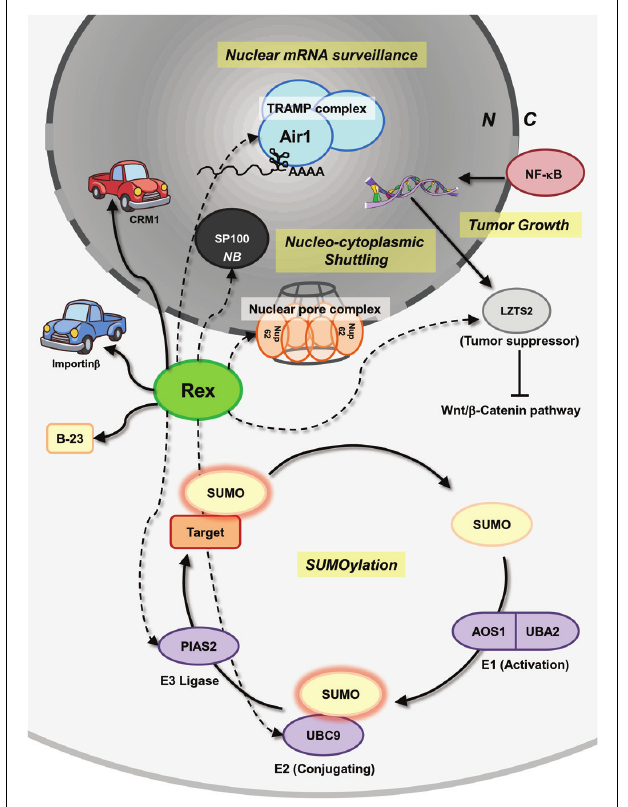
FIGURE 5 | Interactions of Rex with host pathways, uncovered and covered. Besides the known interactions between Rex and CRM-1, importin β , and B-23, a number of potential interactions between Rex and cellular proteins, based on the high-throughput yeast two-hybrid system, were reported by Simonis etal. (2012). Rex is suspected of interacting with a series of proteins that play crucial roles in mRNA surveillance, nucleocytoplasmic shuttling, tumor growth regulation, and SUMOylation. Air1 (ZCCHC7) is a component of theTRAMP complex, which is involved in nuclear mRNA surveillance. NUP62 is one of three nucleoporins (NUP54, 58, and 62) composing the nuclear pore complex and is essential for nuclear transport. LZTS2 is a tumor suppressor and its expression is transcriptionally regulated by NF- κ B. LZTS2 expression levels affect cell proliferation and tumor growth through theWnt/ β -catenin pathway in various cancer cell lines. An E2 SUMO ligase, UBC9, and an E3 SUMO ligase, PIAS2, are also expected to interact with Rex. Rex is also expected to interact with SP100, a major component of the nuclear body, which has a transactivating function and is induced in stimulated and malignant cells. Since Rex impacts the host cell through an unknown mechanism, such as increasing il-2r α mRNA level and fyn-b mRNA expression level by enhancing unusual exon 7 usage, unknown interactions between Rex and cellular proteins may be related to Rex functions. Solid lines indicate reported interactions. Dashed lines indicate potential interactions. N, nucleus; C, cytoplasm; NB, nuclear